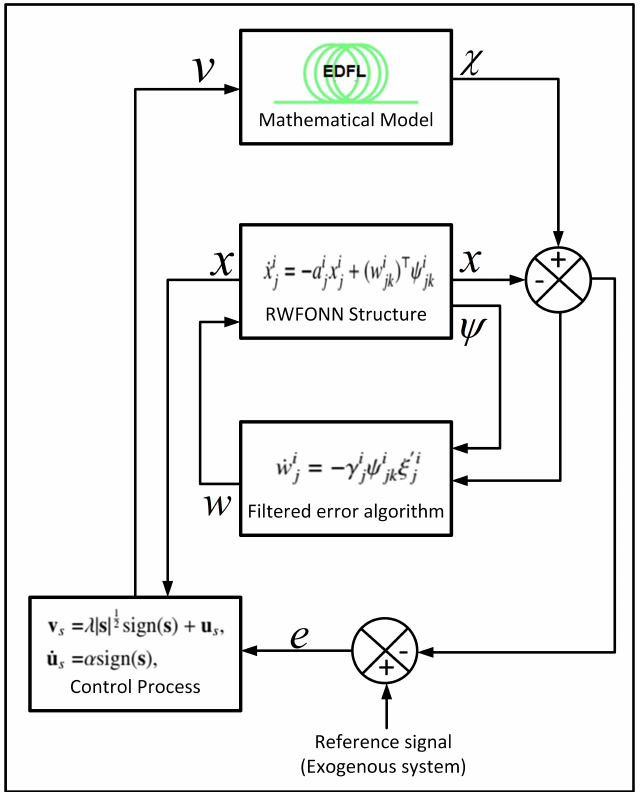
Figure 1. Methodology flowchart of neural identification and